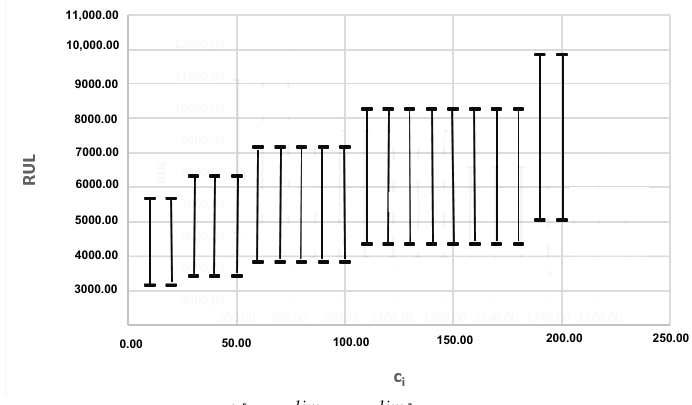
Figure 11. Variations of [ RUL lim